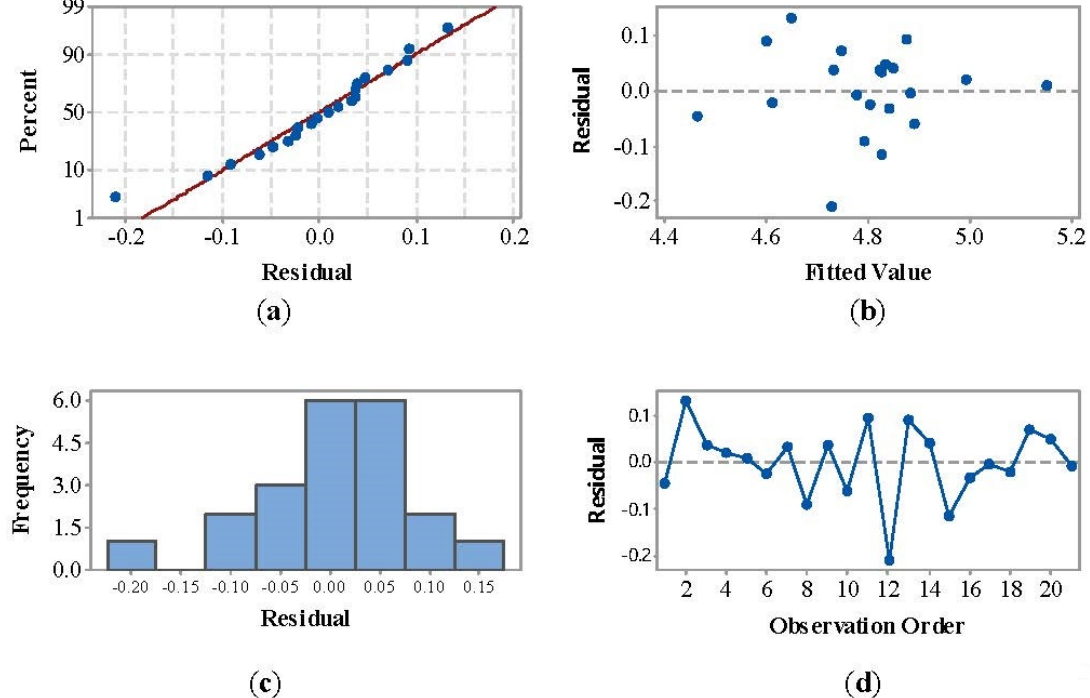
Figure 10. Residual plots for SR ( µ m). ( a ) Normal Probability plot. ( b ) Versus Fits. ( c ) Histogram. ( d ) Versus Order. Table 6. The comparative results of experimental data and fitting data.